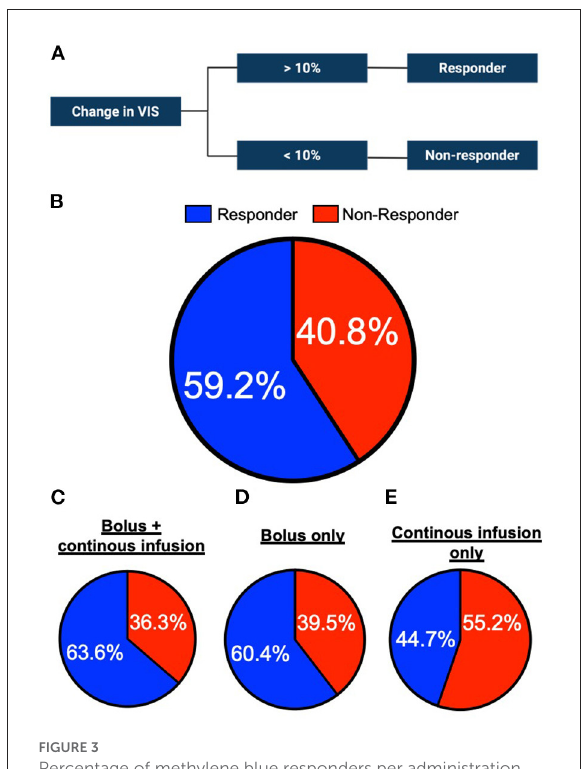
FIGURE3 Percentage of methylene blue responders per administration group. (A) Schematic of the definition of responder or non-responder status to methylene blue treatment. (B) Proportion of responders and non-responders in the study cohort ( n = 196 in total) (C) bolus + continuous infusion cohort ( n = 110 in total) (D) bolus only infusion group ( n = 48) or (E) continuous only cohort ( n =